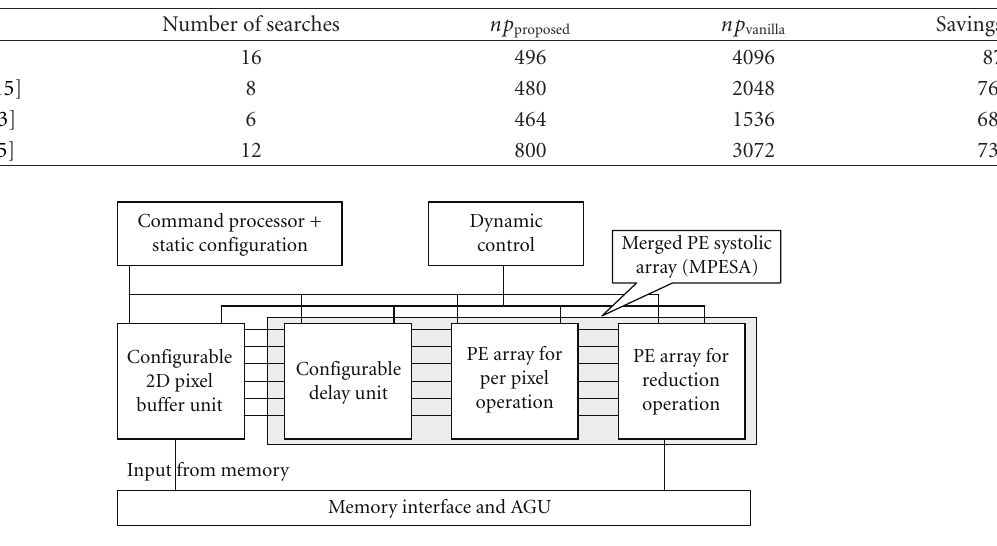
Figure 5: Top-level block diagram of the proposed context-adaptable SAD/MSE